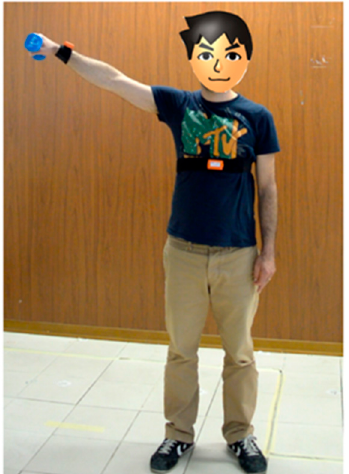
Figure 11. Exercise execution example.